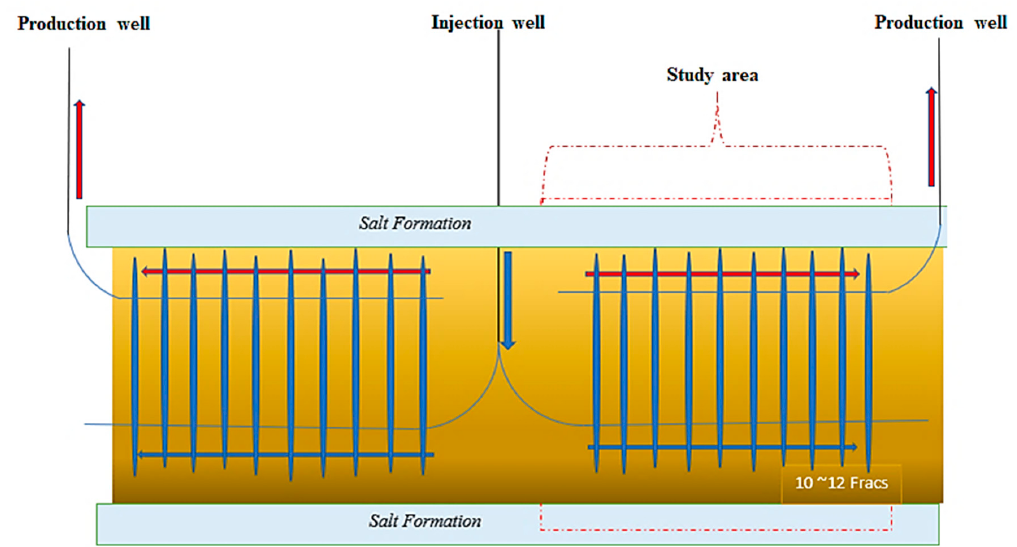
Figure 15. Schematic of the proposed multiple fracture pattern through multi-wells of water injection and production.